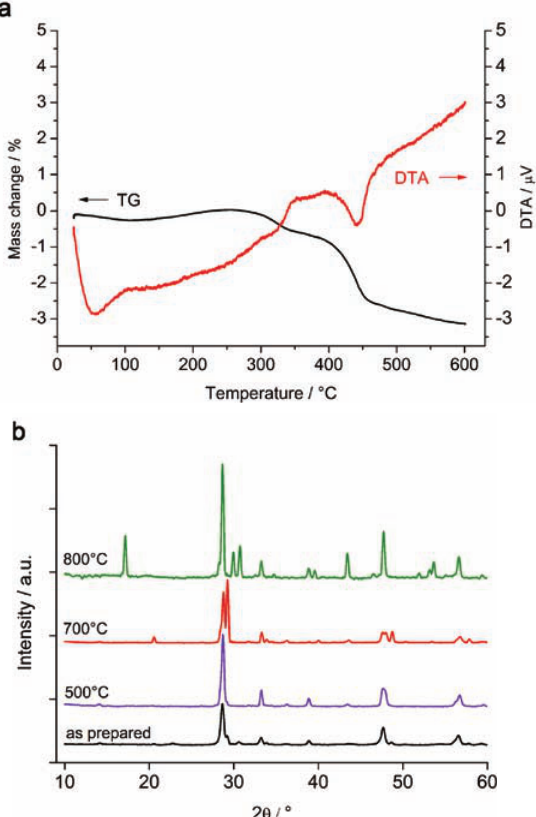
Fig. 4 (a) Differential thermal analysis (DTA) and thermal gravimetric (TG) signals of NaYF Tm nanoparticles and (b) XRD diffraction pat- terns for different sintering temperatures of NaYF :Yb, Er. 500 ℃ and 700 ℃ sintering was 4 applied at a 10 ℃ min -1 heating rate. For 800 ℃ , a “fast” heating is achieved by placing the powder directly into the preheated